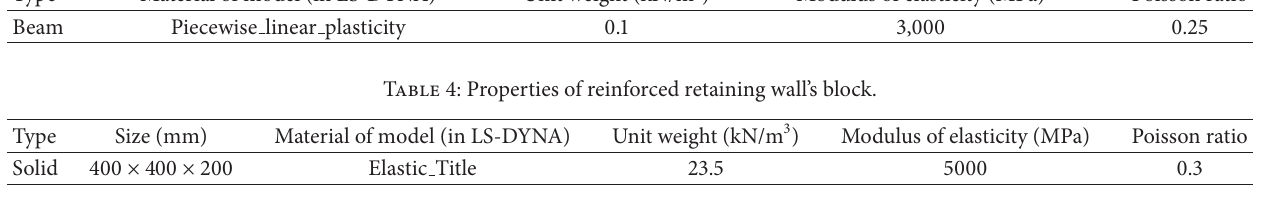
Table 5: Properties of crushed stone and backfill.